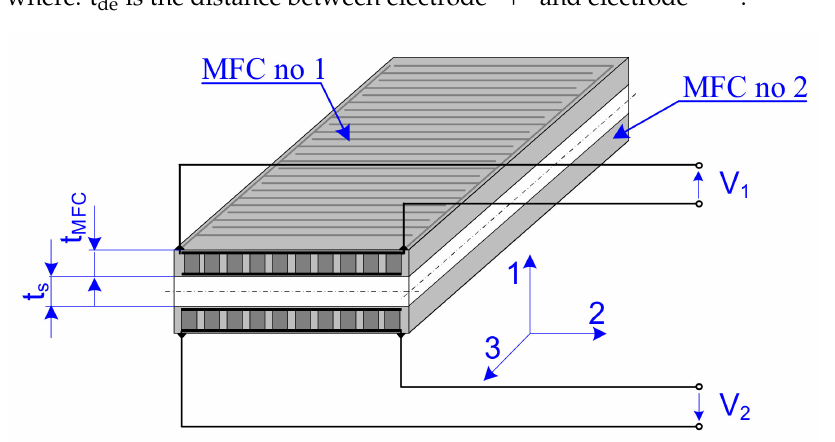
Figure 2. Coordinate system for composite beam: t MFC —thickness of MFC patch, t s —thickness of